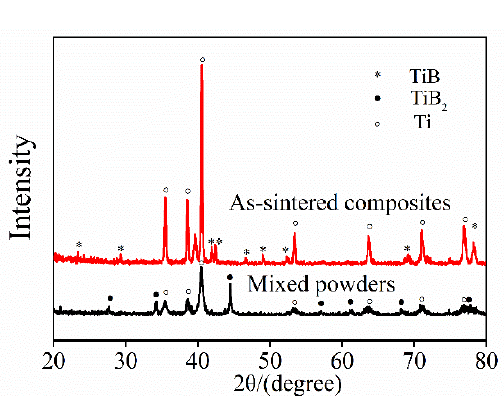
Figure 2. The XRD of mixed powders and as-sintered composites.